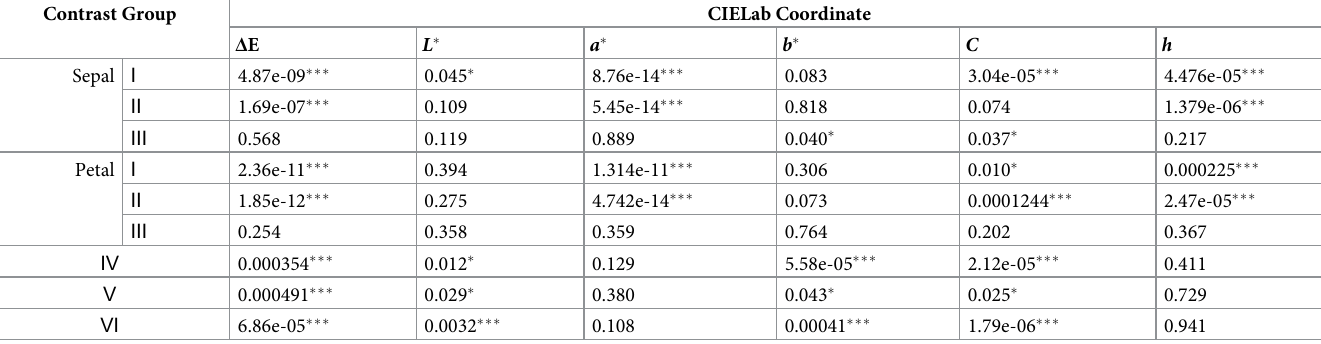
Table 2. The p value of the Mann-Whitney U test between different parts of sepal and petal color. Contrast Group